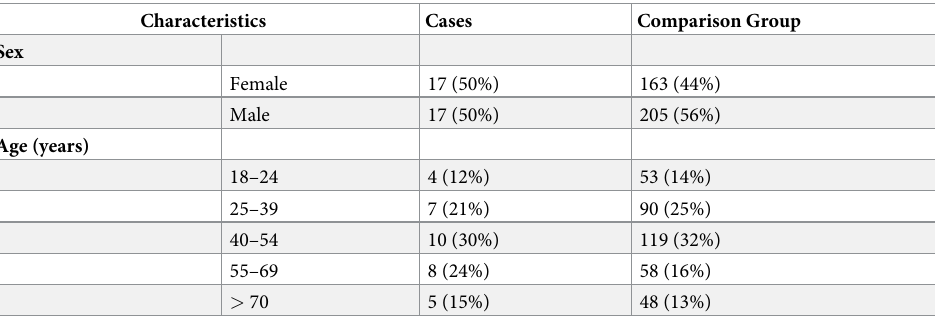
Table 4. Demographic characteristics of GBS cases and sampled normal population, Barranquilla,